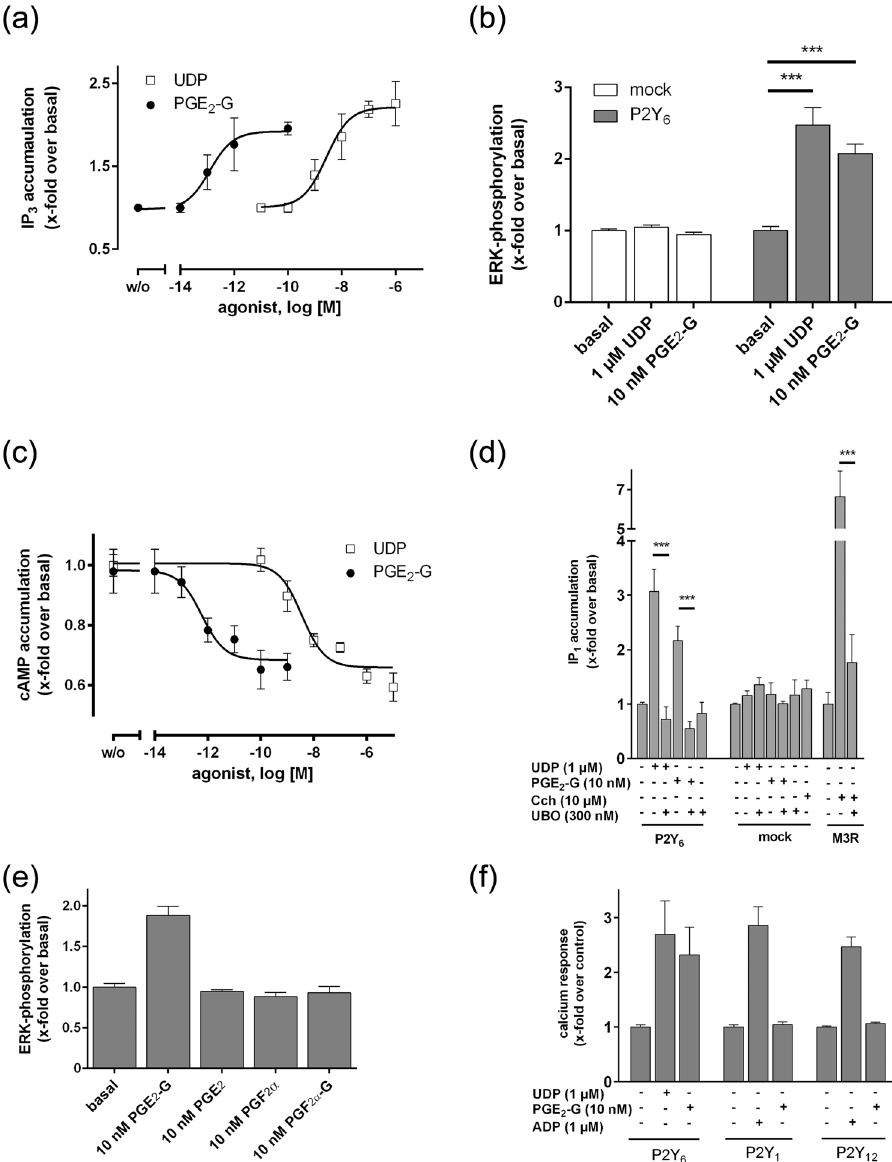
Figure 3. P2Y6 activated by UDP- and PGE2-G couples to Gq- and Gi/o proteins. ( a ) In an IP 3 assay with P2RY6-transfected HEK293 cells, UDP and PGE cells were treated with the indicated concentrations of UDP and PGE 2 -G, and ERK phosphorylation was measured with the AlphaScreen ® SureFire ERK 1/2 assay. ( c ) In a cAMP-inhibition assay HEK293 cells transfected with P2RY6 were incubated with various concentrations of PGE 2 -G or UDP in the presence of 2.5 µ M forskolin ( see Methods ). The EC 50 values of PGE 2 -G and UDP were 0.6 ± 0.2 pM and 3.6 ± 0.3 nM, respectively. Basal cAMP levels before and after stimulation with forskolin were 2.3 ± 0.6 and 106 ± 7.3